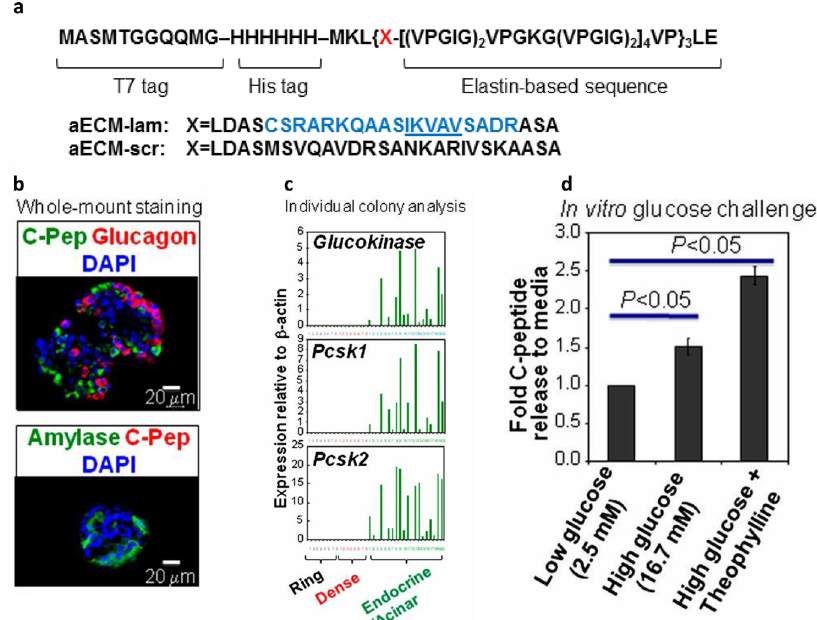
Fig. 6 Generating pancreatic organoids with a recombinant ECM protein. An arti fi cial elastin-like polypeptide functionalized with a sequence from laminin can be used to generate organoids from pancreatic ductal progenitor cells from adult mice. ( a ) The recombinant protein (named aECM-lam) incorporates an IKVAV-containing 18-amino acid sequence derived from α 1 laminin. The aECM-scr is a scrambled sequence control for aECM-lam. ( b ) aECM-lam permits the differentiation of endocrine (expressing C-peptide and glucagon) and acinar cell lineages (expressing amylase). ( c ) Individual organoids (Endocrine/Acinar) grown in aECM-lam express beta-cell maturation markers glucokinase, Pcsk1 , and Pcsk2 . ( d ) Organoids grown in aECM-lam are capable of secreting insulin in vitro when challenged by high concentrations of D -glucose or a combination of D -glucose and cAMP activator theophylline. The image is from ref. 192 and is reproduced with